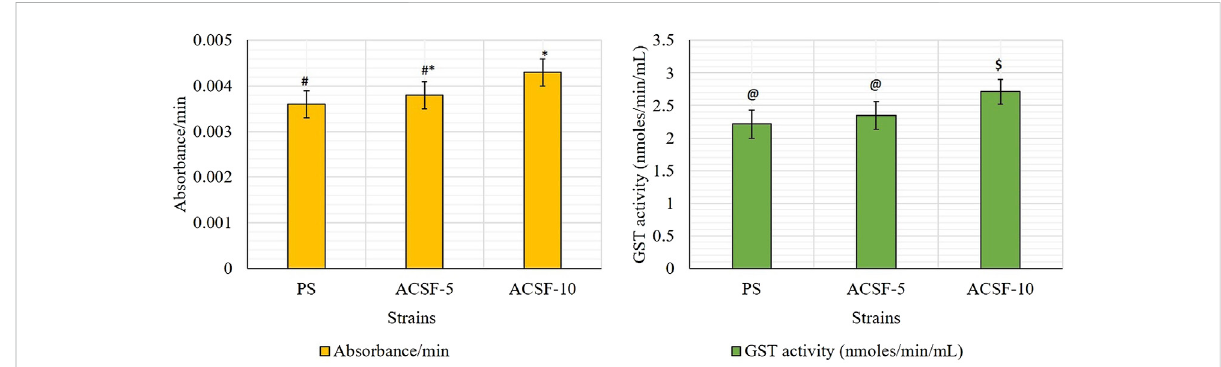
signi fi cantly different ( p < 0.05); computed by one-way ANOVA followed by Tukey ’ s all pairwise multiple comparison test.